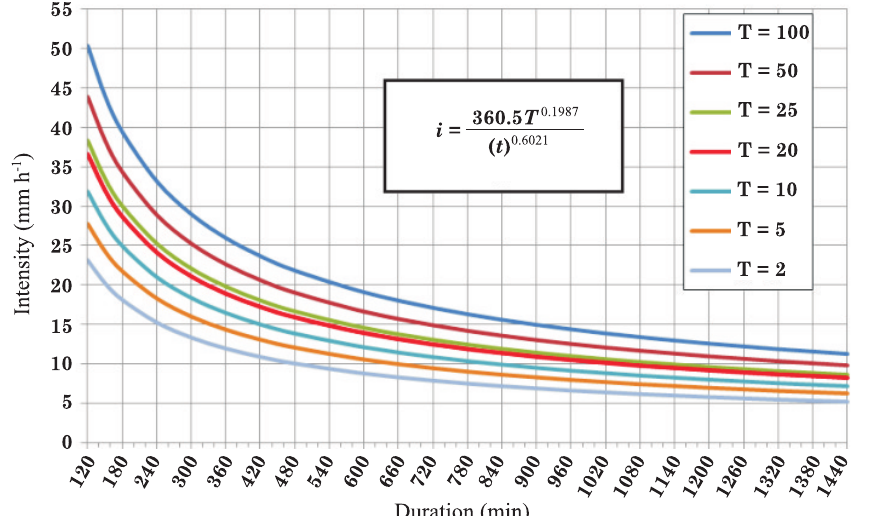
Figure 3. Equation of heavy rainfall events for durations from 120 to 1440 min, adjusted to Urussanga, Santa